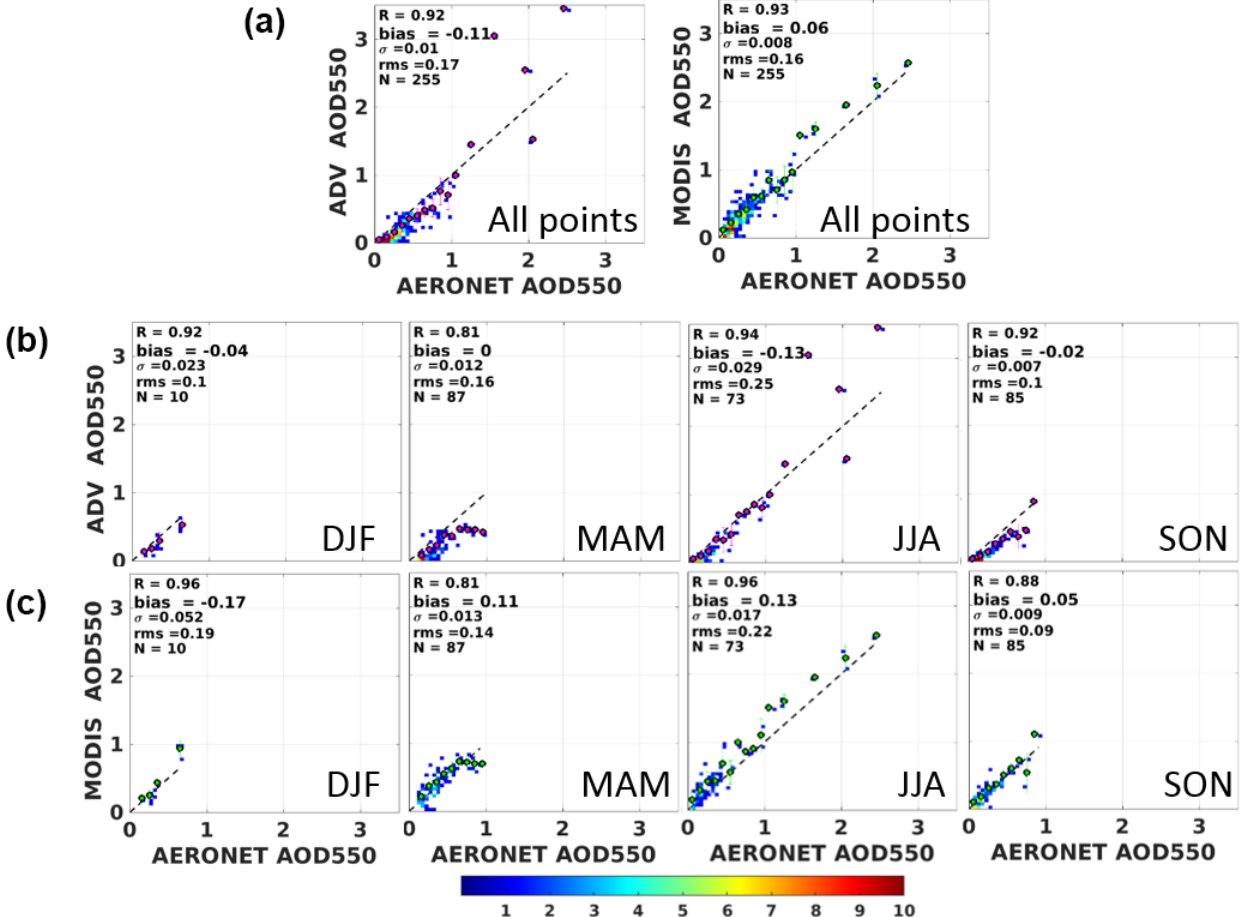
Figure 8. Density scatterplots of collocated ATSR ADV v2.31 AOD and MODIS C6.1 DTDB merged AOD vs. AOD from AERONET stations in China for the years 2002–2011: all points (a) and seasonal statistics ( b for ADV and c for MODIS). The color bar at the bottom indicates the number of data points.